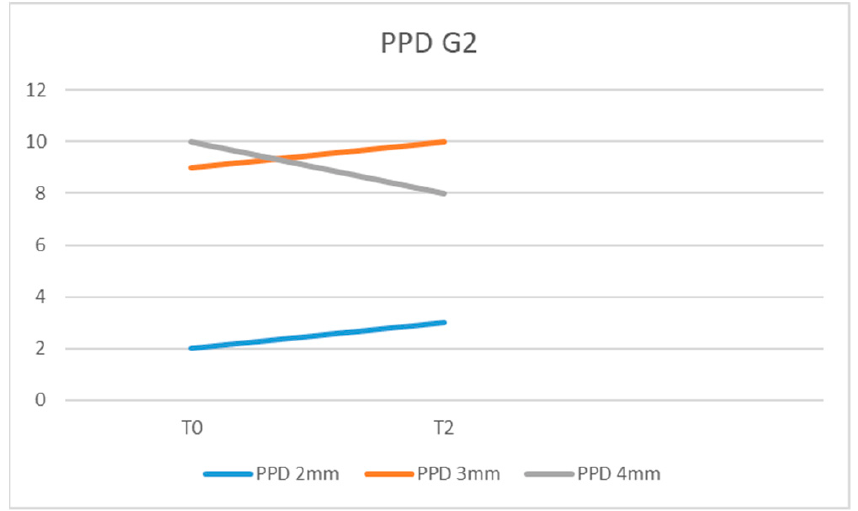
patients, PPD = 3 mm in 9, and PPD = 2 mm in 2 of them (Figure 5).